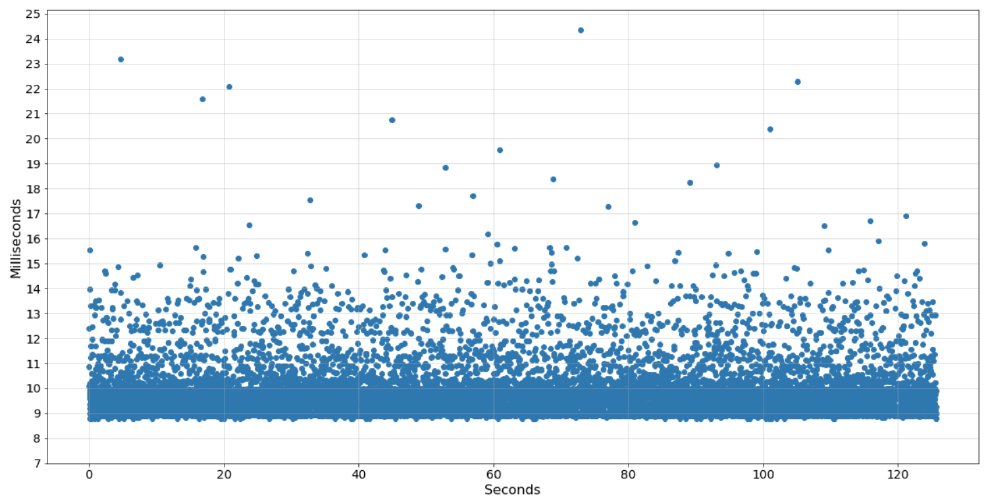
Figure 3. ∆ Time of IMU samples collected by the wearable system.